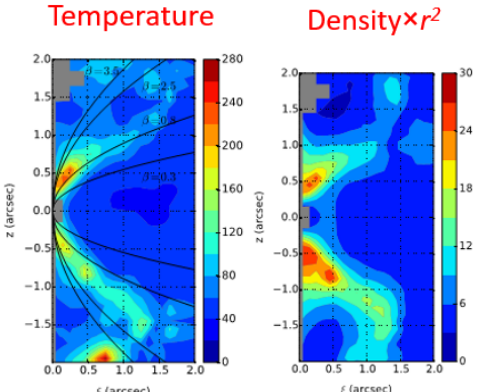
Fig. 5 Meridian distributions of temperature (left) and density multiplied by the square of the distance to the central star